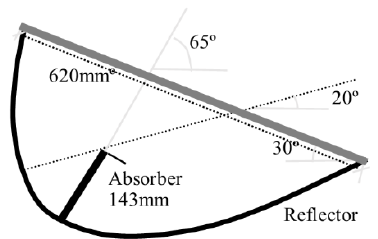
Figure 3. Diagram of stand-alone MaReCo for Stockholm conditions with cover glass angle of 30° [15].